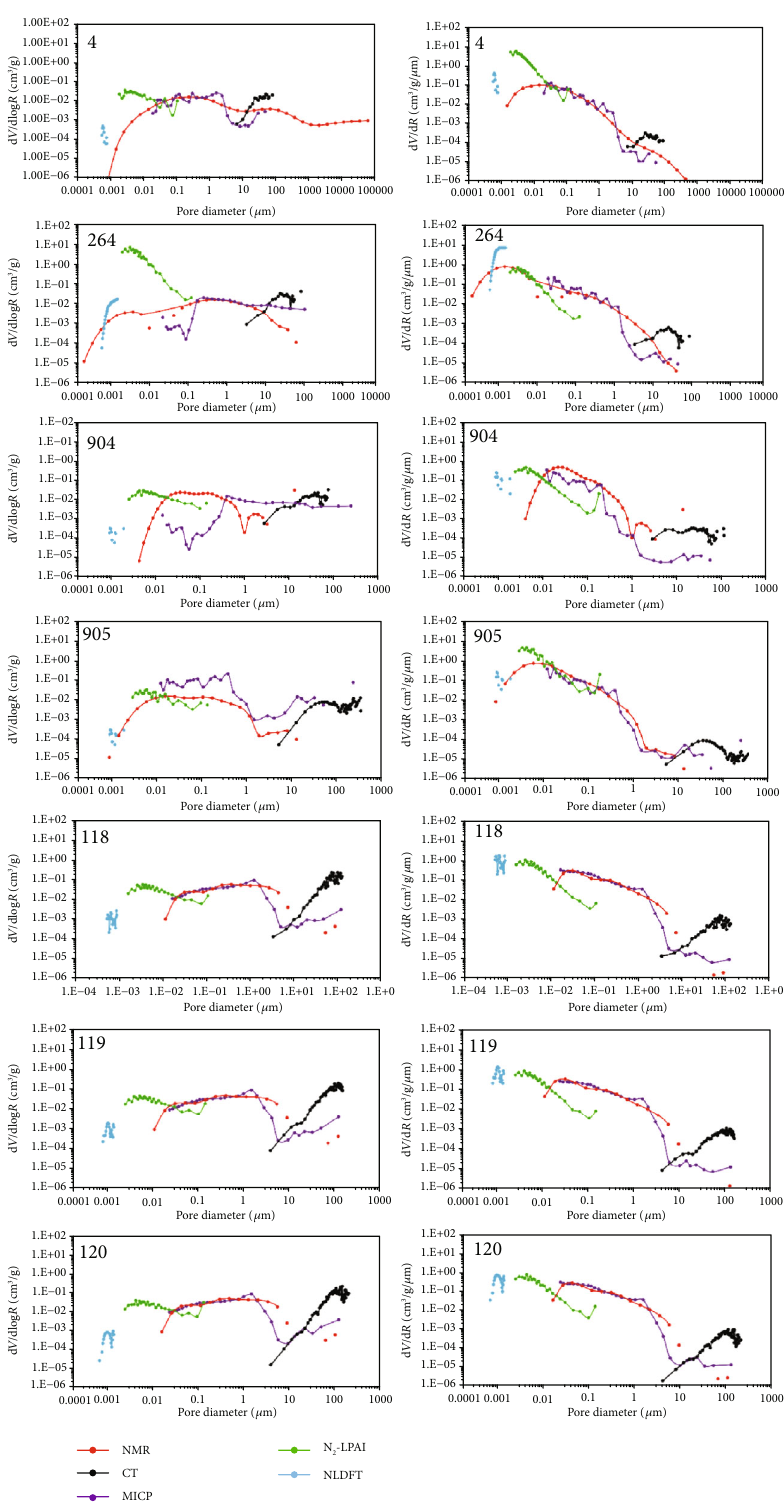
Figure 12: Comparison of the d V /dlog R curves and d V /d R curves data